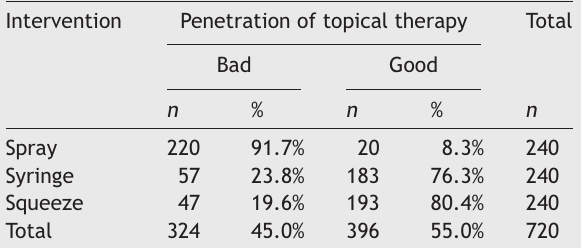
Penetration of topical therapy with Sutured Middle